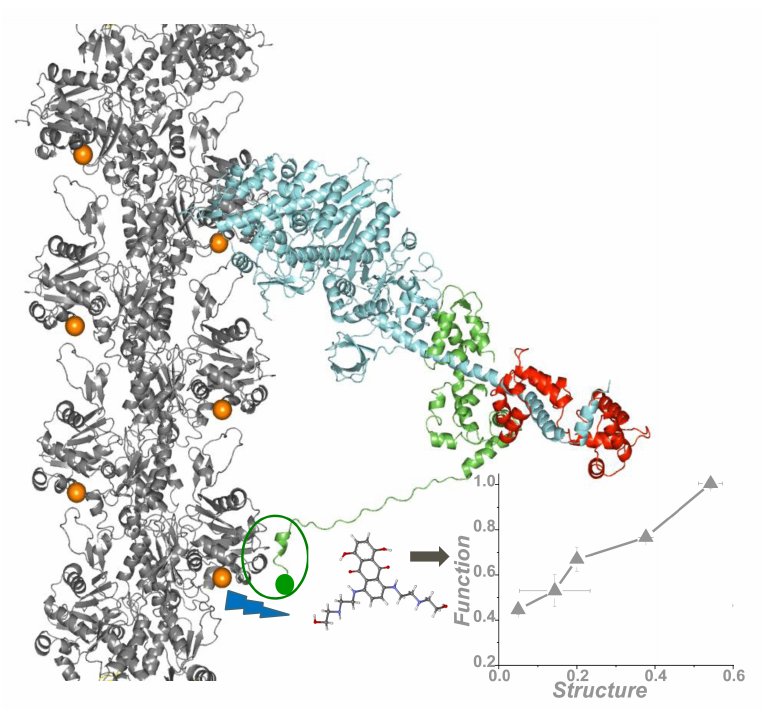
Figure 6. High-throughput fluorescence resonance energy transfer (FRET) from actin labeled at the C-terminus (orange spheres) to a peptide derived from the N terminus (green sphere) of the myosin essential light chain, detects actin-binding compounds that change actomyosin structure and function. Adapted from the cover of Guhathakurta, P.; Prochniewicz, E.; Grant, B.D.; Peterson, K.C.; Thomas, D.D. High-throughput screen, using time-resolved FRET, yields actin-binding compounds that modulate actin-myosin structure and function. J . Biol . Chem . 2018 , 293 , 12288–12298